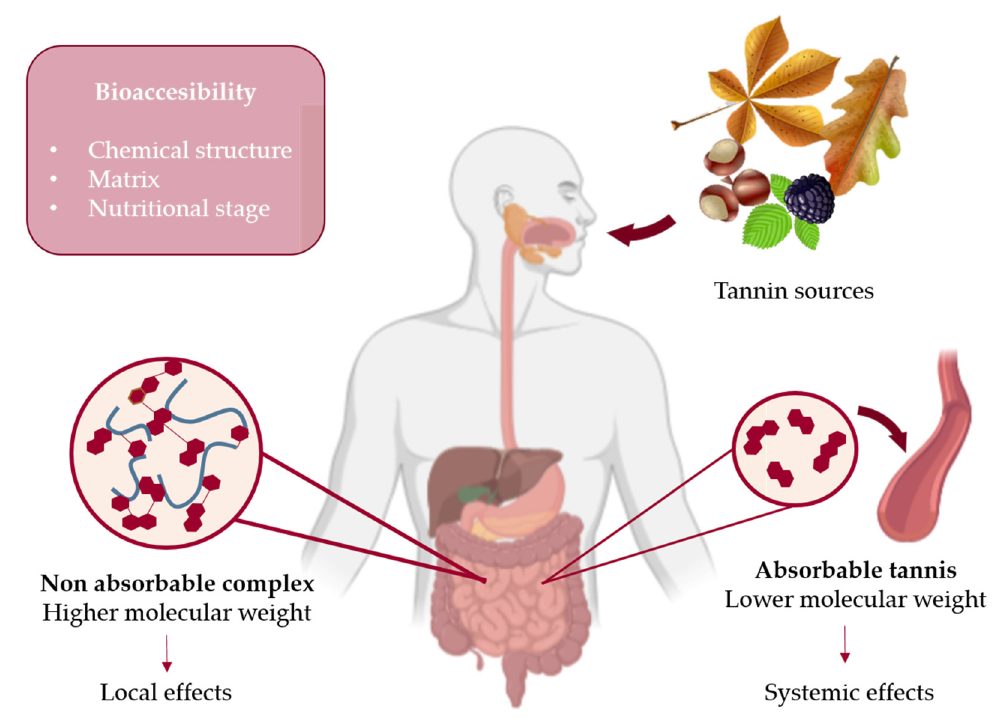
Figure 4. Bioaccessibility and bioavailability of tannins.